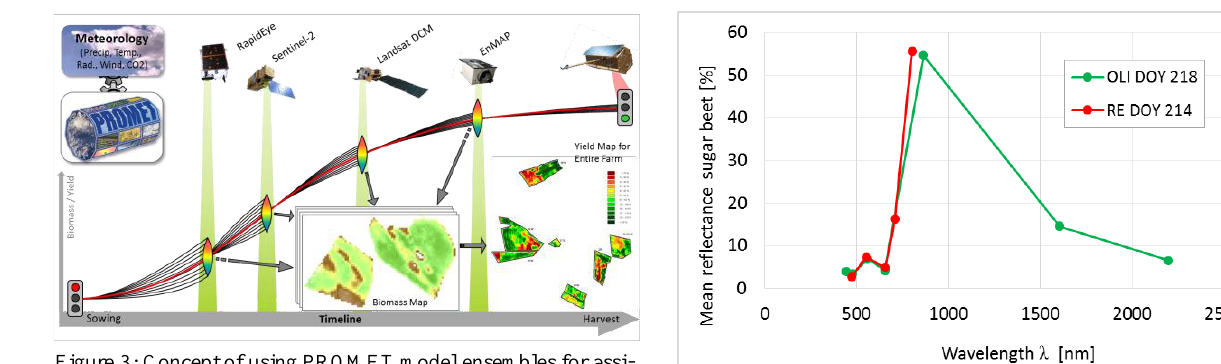
Figure 3: Concept of using PROMET model ensembles for assi- milating multi-sensoral remote sensing data, modified after Hank et al. 2015